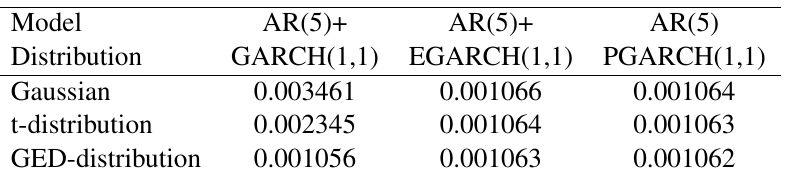
Table 2. Ex post forecast RMSEs for various extensions of GARCH